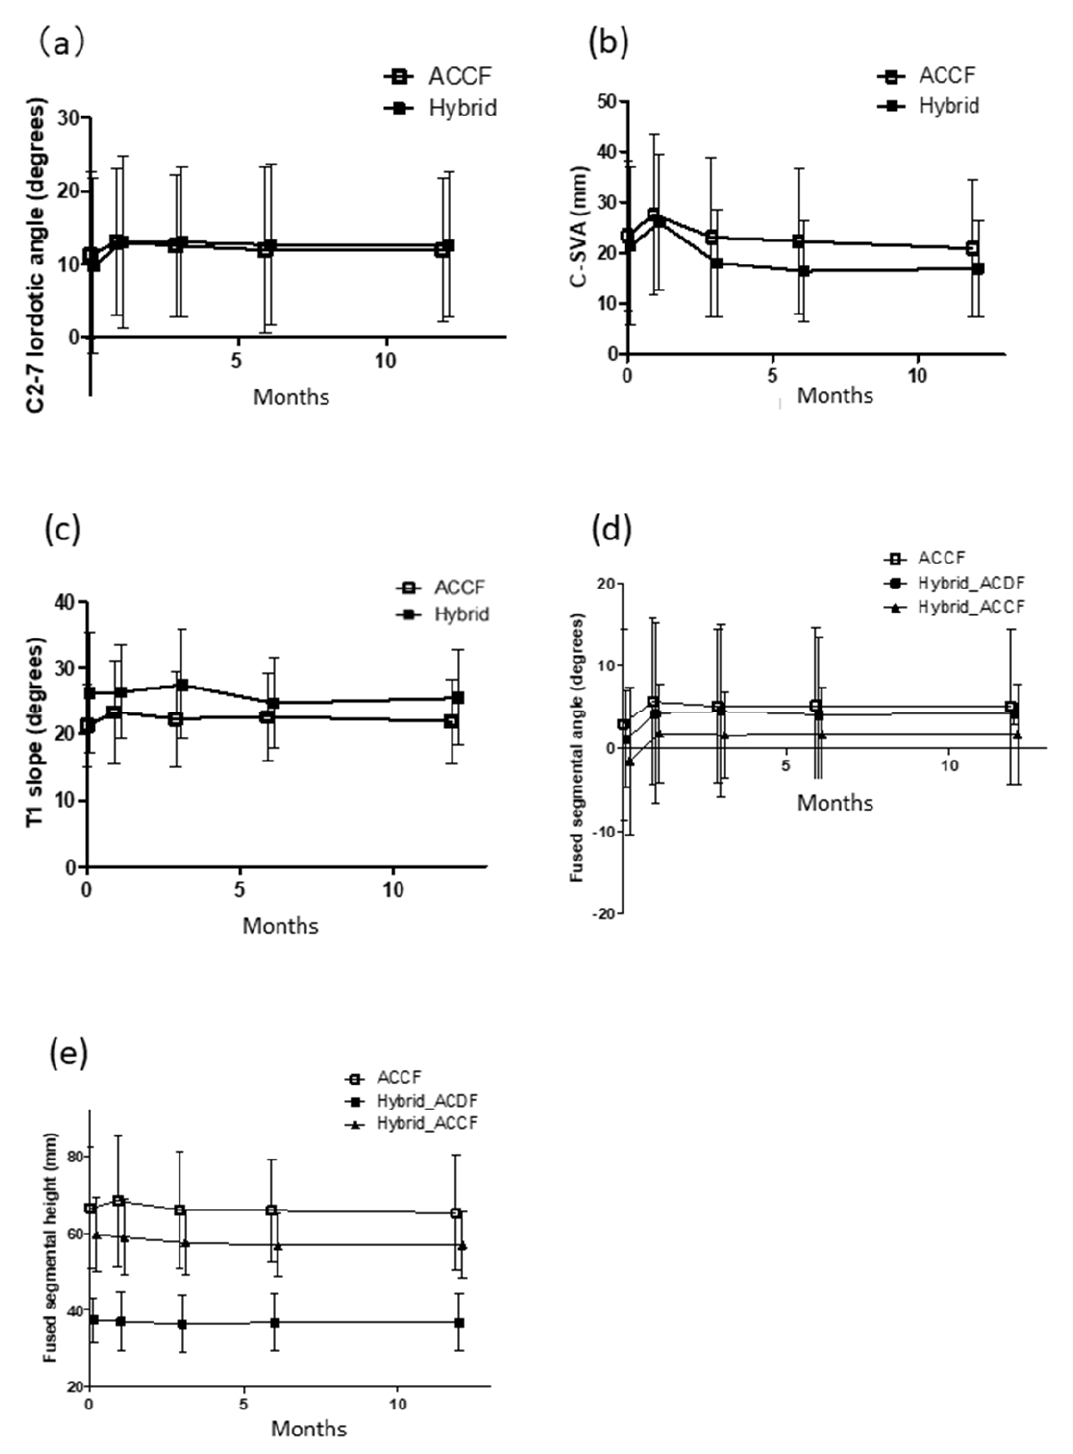
Figure 2. Radiographic measurement of ( a ) C2–7 angle; ( b ) C2–7 SVA; ( c ) T1 slope; ( d ) FSA; and ( e ) FSH in the ACCF and hybrid